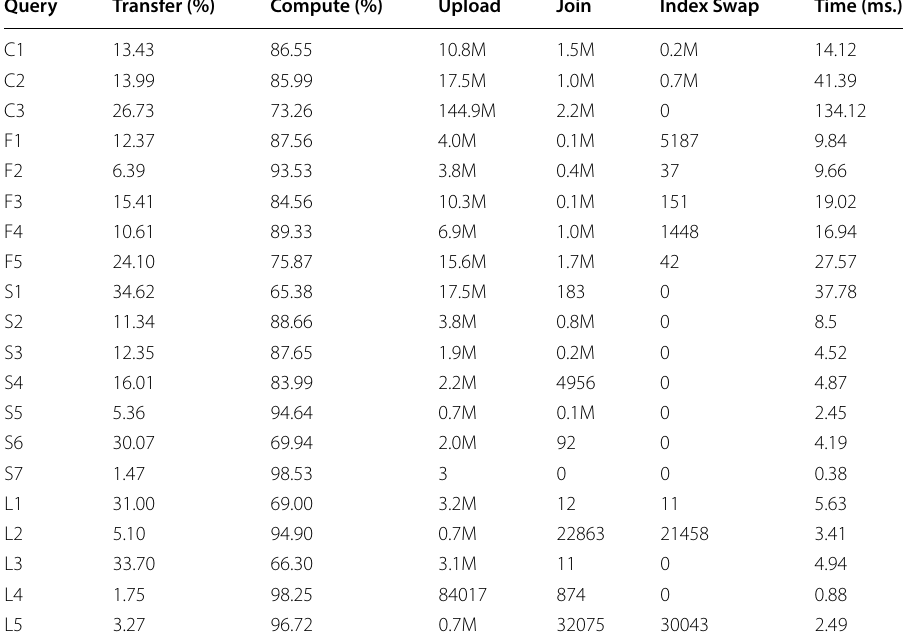
Table 7 Query processing time analysis for WatDiv 300M data